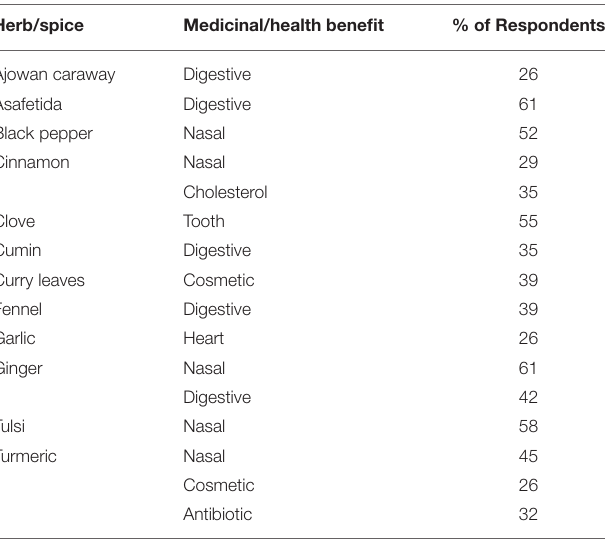
TABLE 6 | Herbs and spices with > 25% consistency of medicinal/health benefits among southern California Indian immigrant women. Herb/spice Medicinal/health